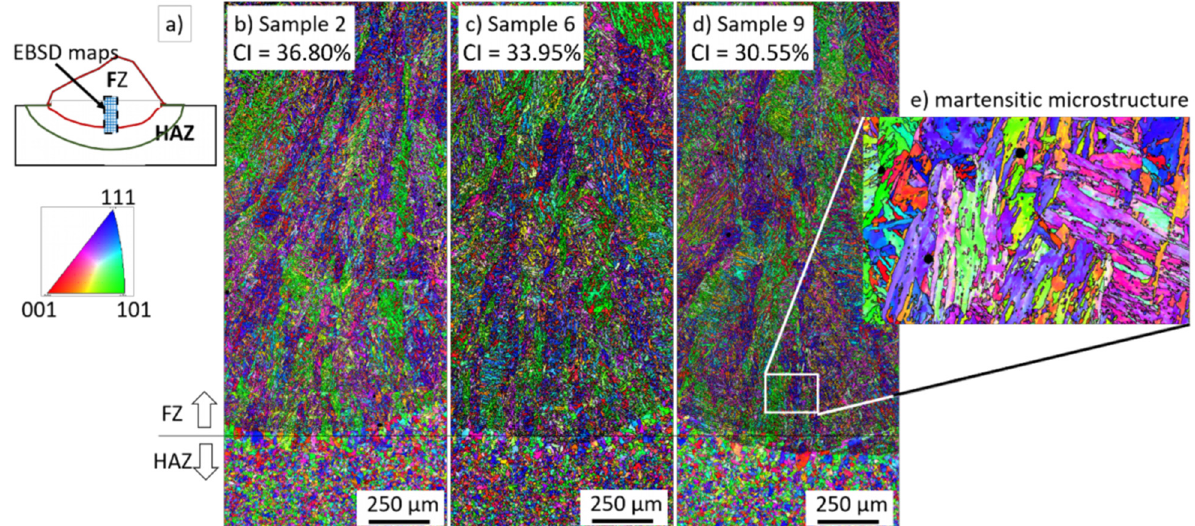
Figure 9. EBSD results of the FZ and HAZ, mainly the upper part, the CGHAZ: ( a ) schematic view where the macros view were taken, ( b ) IPF map of samples 2, ( c ) IPF map of sample 6, ( d ) IPF map of sample 9, ( e ) detailed view from sample 9, showing the formation of martensite blocks and laths inside the microstructure.